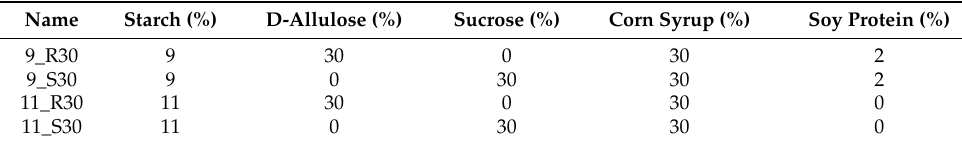
Table 3. Composition of the